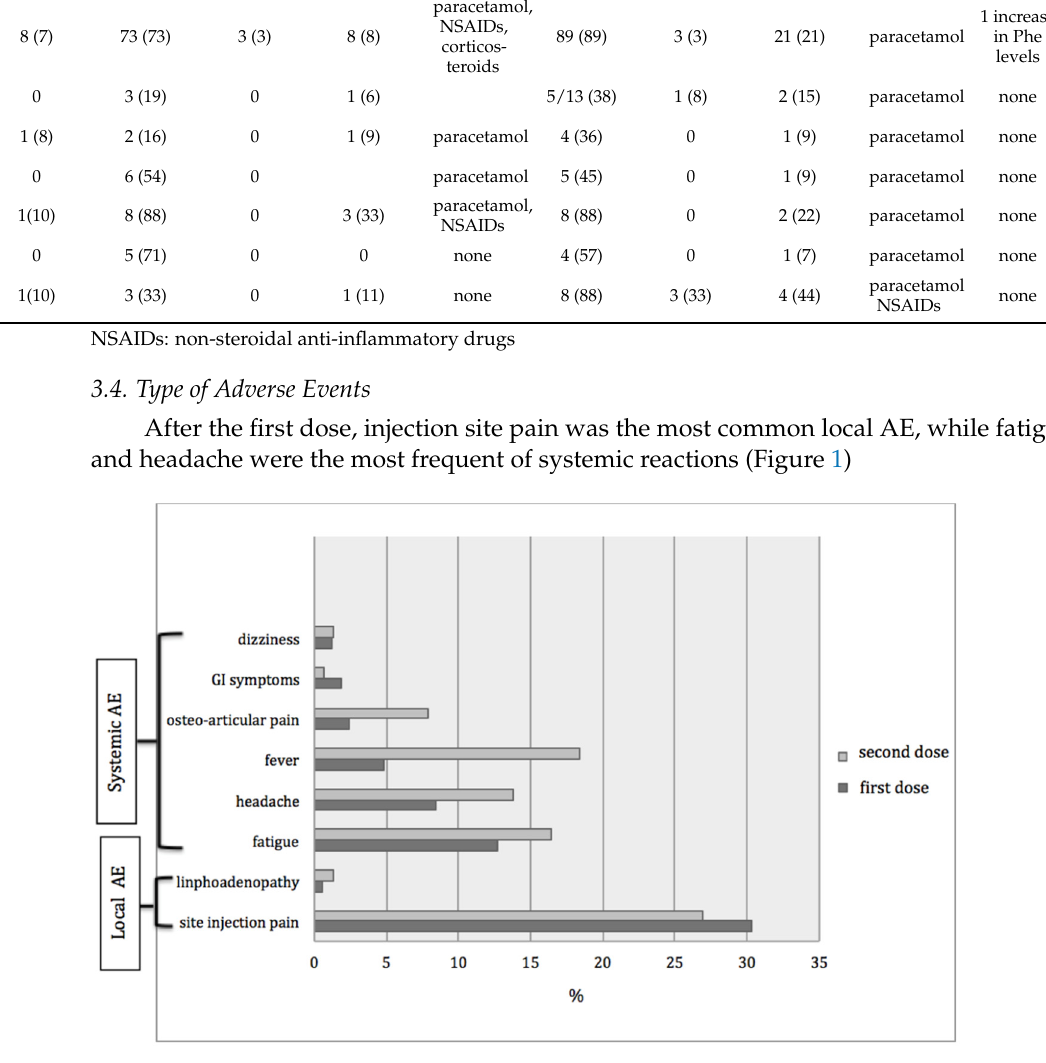
Figure 1. Rates and types of AEs after the first and second dose of COVID-19